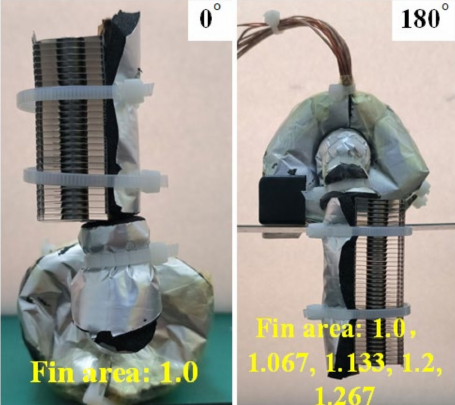
Figure 14. Specimen testing at an inclination angle of 0 and 180 degrees.